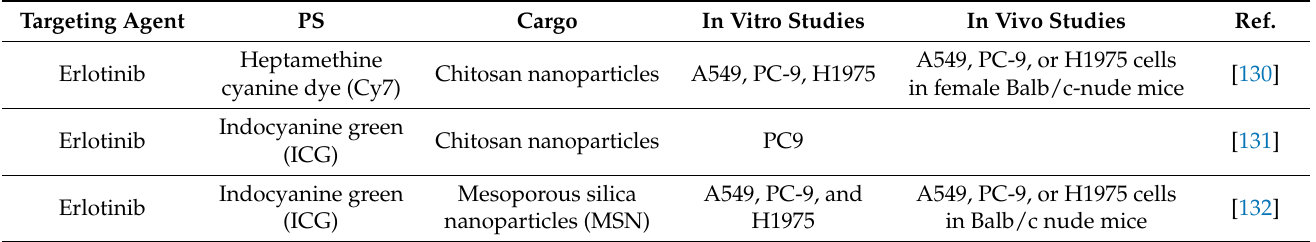
Table 6. EGFR-targeted PDT performed with EGFR ligands as targeting agents and conjugated with carrier